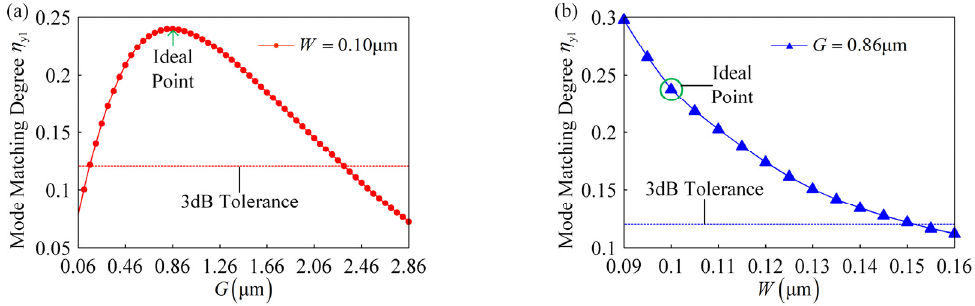
Figure 5. ( a ) 3 dB fabrication tolerance of the gap G when width W is 0.10 µm. ( b ) 3 dB fabrication tolerance of the width W when gap G is 0.86 µm.